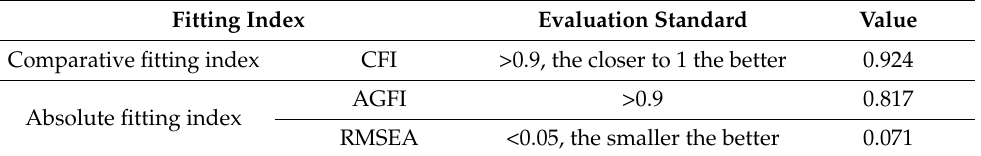
Table A2. Model fitting index.